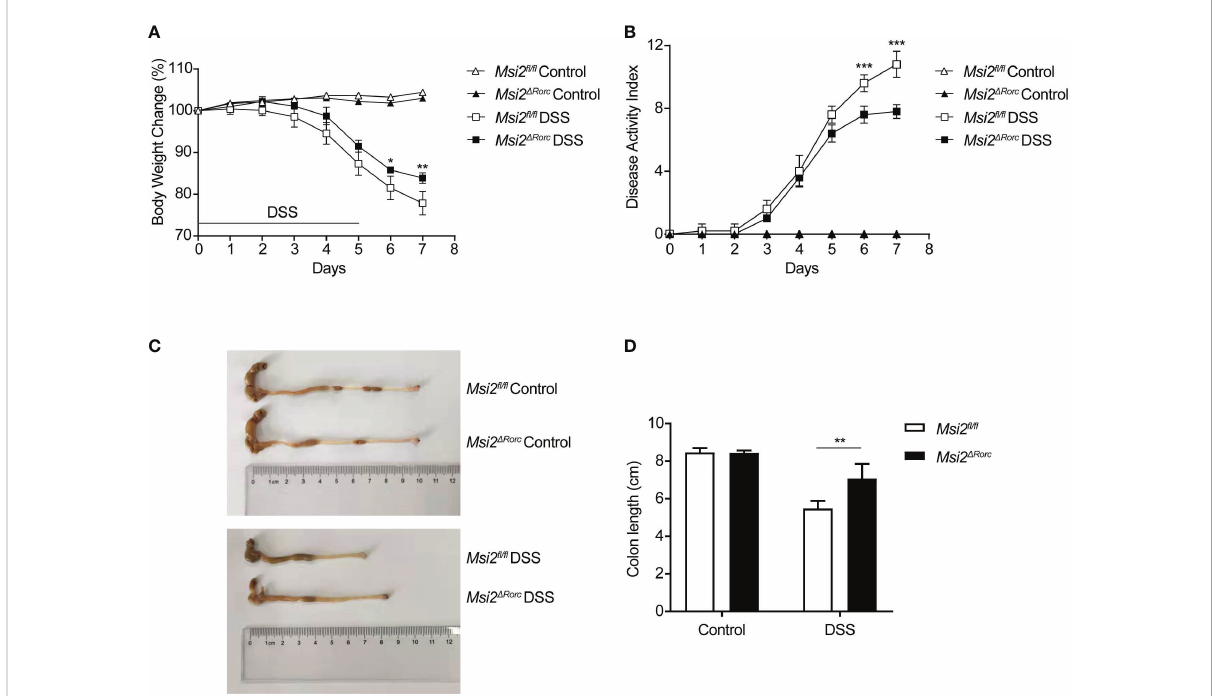
FIGURE 2 Msi2 D Rorc mice are resistant to DSS-induced colitis. Msi2 fl / fl and Msi2 D Rorc mice were fed with 4% DSS or water ad libitum for 5 days followed by recovery on normal drinking water for 2 days prior to euthanasia. (A) The body weight change was evaluated daily. (B) The disease activity index (DAI) was scored daily. (C, D) Representative images of colons from Msi2 fl / fl and Msi2 D Rorc mice on day 8, when the colon length were examined. Data represent the means ± SEMs (n=5). *p < 0.05, **p < 0.01, ***p <